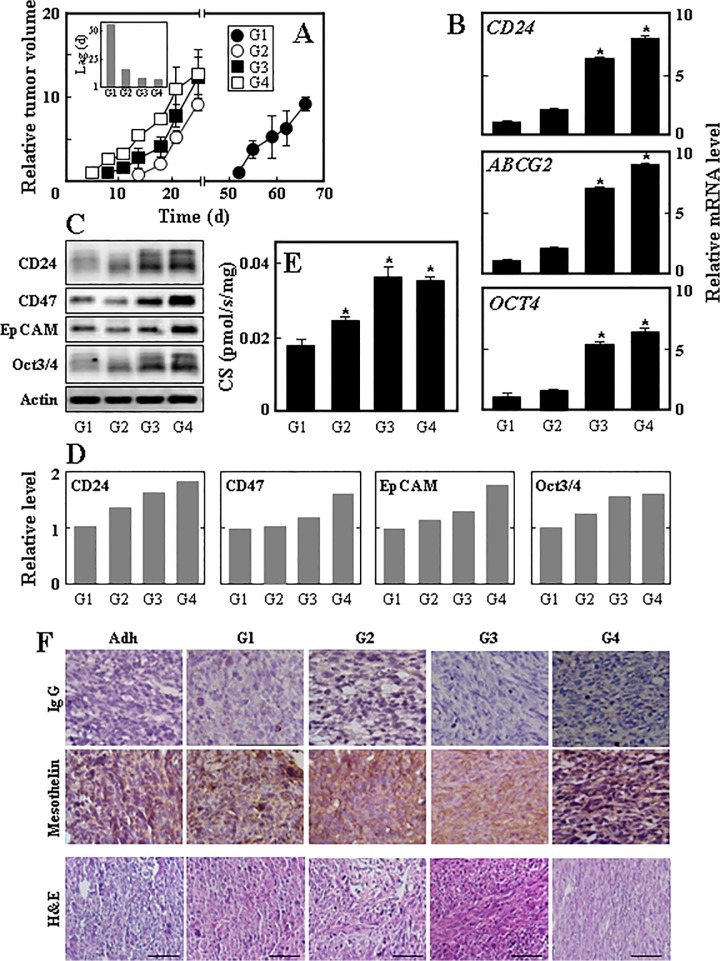
Mesospheres form tumours in serial transplantations.(A) Ist-Mes-2 sphere cells (generation 1, G1) were subcutaneously grafted into Balb-c/nude mice at 106 cells per animal. When tumours reached about 2,000 mm3, the mice were sacrificed, tumours excised and malignant cells grew in vitro as a cell line. The adherent cells were converted into spheres (G1) and these were grafted into Balb-c/nude mice to form tumours that were used for generation 2 (G2) spheres. This procedure was repeated two more times to derive G3 and G4 spheres. The inset in panel A shows the lag to tumour appearance following cell grafting for individual sphere cell generations. Cells of individual generations were evaluated for stemness markers as shown using qPCR (B) and WB (panel C shows the blots, panel D their densitometric evaluations) and for CS activity (E). (F) Tumours derived from adherent cells and spheres of individual generations were excised, paraffin-embedded and stained for the MM marker mesothelin (upper images show staining with the exclusion of the primary IgG) and with H&E. Data shown in panel A are derived from 5 animals and are mean values ± S.E.M, data in panels B and E are mean values from three independent experiments ± S.D. Images in panel C are representative of two individual experiments and their densitometric evaluations in panel D represent mean values with differences lower than 10%. Images in panel F were obtained using one tumour for each condition (generation). The symbol ‘*’ denotes statistically significant differences with p<0.05. Images are representative of three different tumours.